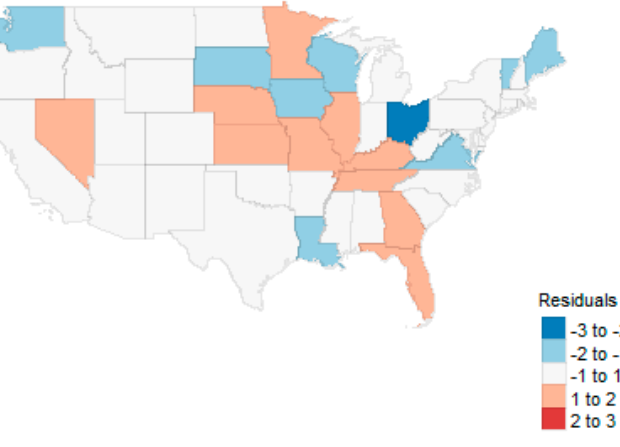
Figure 12. Map of regression residuals.